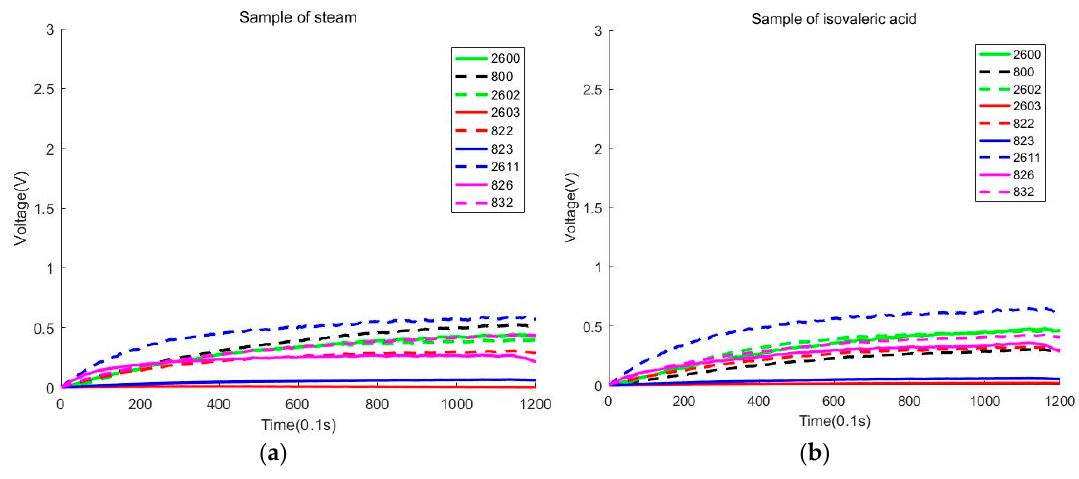
Figure 7. ( a ) Sample of steam. ( b ) Sample of isovaleric acid. Figure 7. (a) Sample of steam. (b) Sample of isovaleric acid.